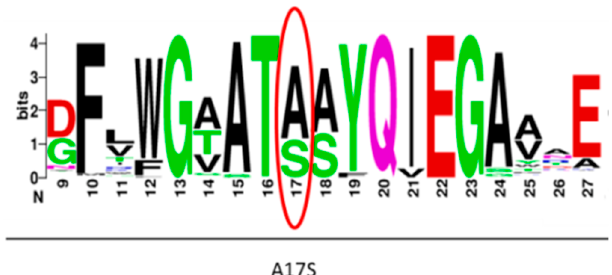
Figure 3. Amino acid frequencies in the residues surrounding the A17S mutation event. The relevant amino acid sequence of C. thermocellum BglA was BLASTed against the NCBI nonredundant protein database. The top 1000 hits were used to create the distribution scheme using WEBLOGO. Position 17 is marked by the red circle.